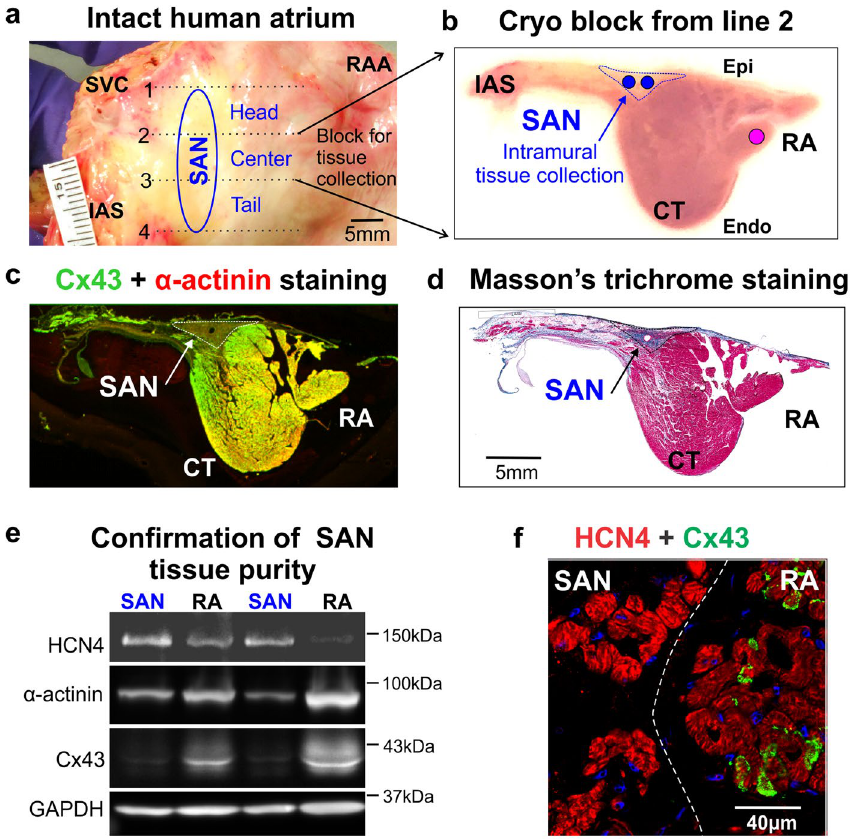
Figure 1. Human SAN pacemaker tissue extraction and validation. ( a ) Image of a human right atrial (RA) preparation. The location of the SAN is represented by the blue oval. The whole SAN pacemaker complex was embedded in a freezing medium (OCT) and cut into three cryo-blocks (head, center and tail). ( b ) Cross view of the SAN center cryo-block cut from line 2 as shown in panel A; blue dotted line indicates the SAN area and the blue and pink circles indicate the locations for tissue biopsy of the SAN and RA, respectively. ( c ) Connexin-43 (Cx43, green) and α-actinin (red) immunostaining show the SAN as a Cx43 negative and α-actinin positive region. ( d ) Masson’s trichrome staining shows the SAN as a highly fibrotic region compared to the atria. ( e ) Representative immunoblots of the SAN versus RA samples with the anti-bodies of HCN4, α-actinin, connexin-43, and GAPDH. The uncropped full-length blots are presented in Supplemental Information file Fig. S1. ( f ) Immunostaining with HCN4 (red) and Cx43 (green) shows negative Cx43 and higher HCN4 expression in the SAN than the RA. CT indicates crista terminalis; Endo/Epi, endo/epicardial; GAPDH, glyceraldehyde 3-phosphate dehydrogenase; HCN4, hyperpolarization-activated cyclic nucleotide-gated channel 4; HF, heart failure; IAS, interatrial septum; RA (A), right atrial (appendage); SAN, sinoatrial node; SVC, superior vena